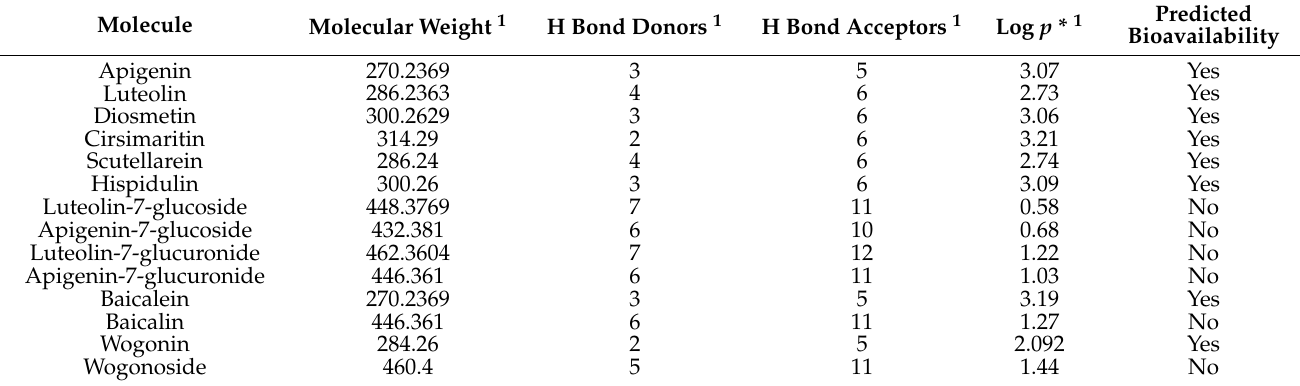
Table 6. Predicted passive absorption of some flavones found in plants of the Ocimum , Origanum , Salvia , and Thymus genus.